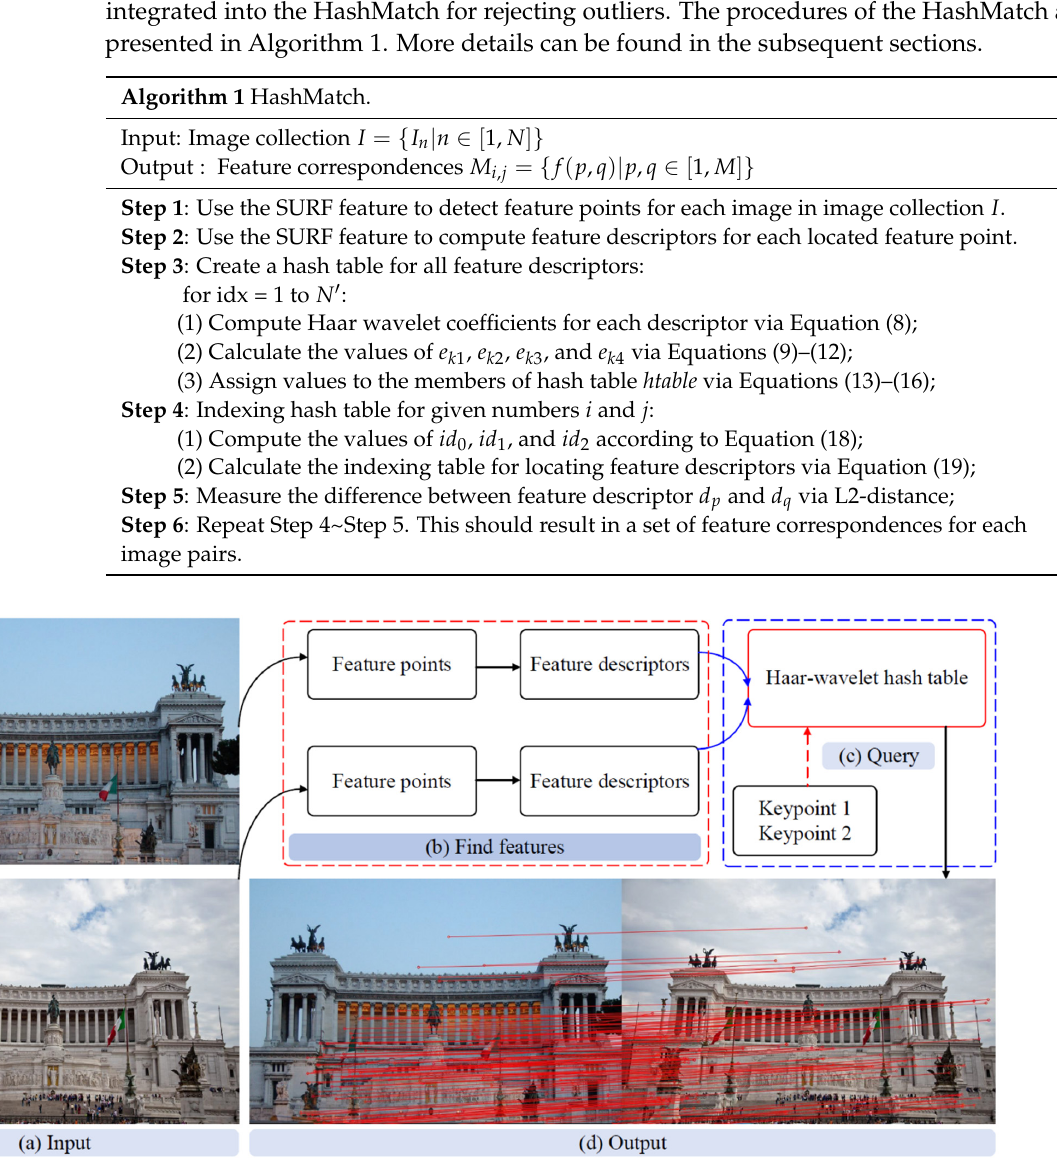
Figure 1. Flowchart of the HashMatch. The core of the proposed method consists of two parts: the first involves finding features including keypoint detection and computing feature descriptor, and the second involves matching feature descriptors by searching the created Haar wavelet hash table. Algorithm 1 HashMatch.